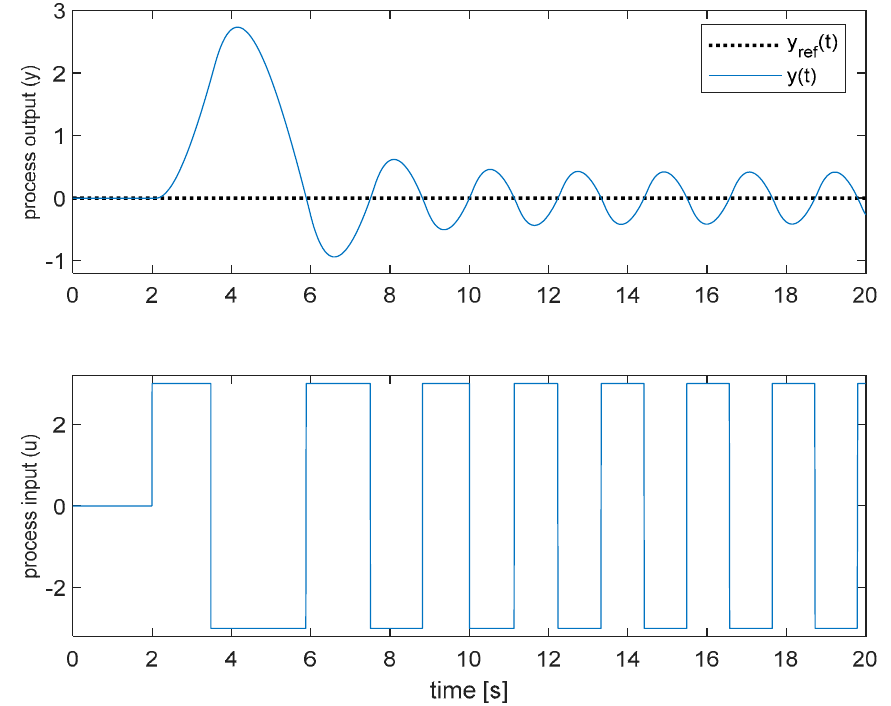
Figure 17. Response of the proposed method for the integrating process and (cid:1842)(cid:1827) (cid:3046)(cid:3032)(cid:3047) = −(cid:2024) .